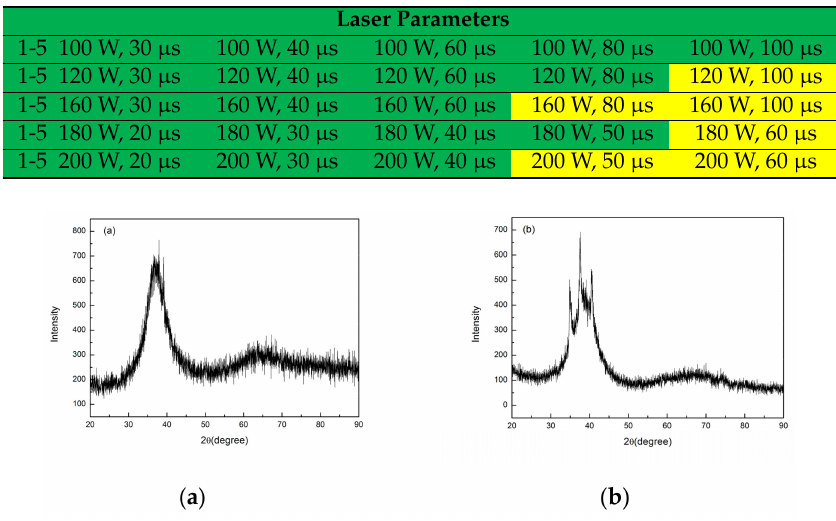
Figure 3. Two typical XRD patterns of the of SLM specimens, ( a ) fully amorphous, ( b ) amorphous with partial